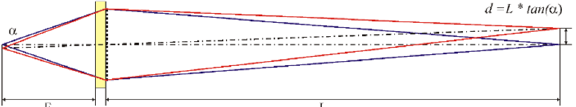
Fig. 5. Shift of the surface vertex marked point due to hologram tilt with respect to